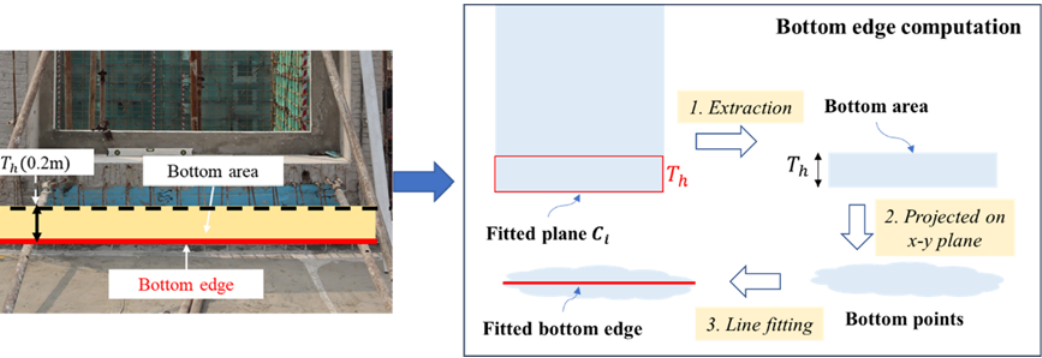
Figure 4. Bottom edge computation of PWP.